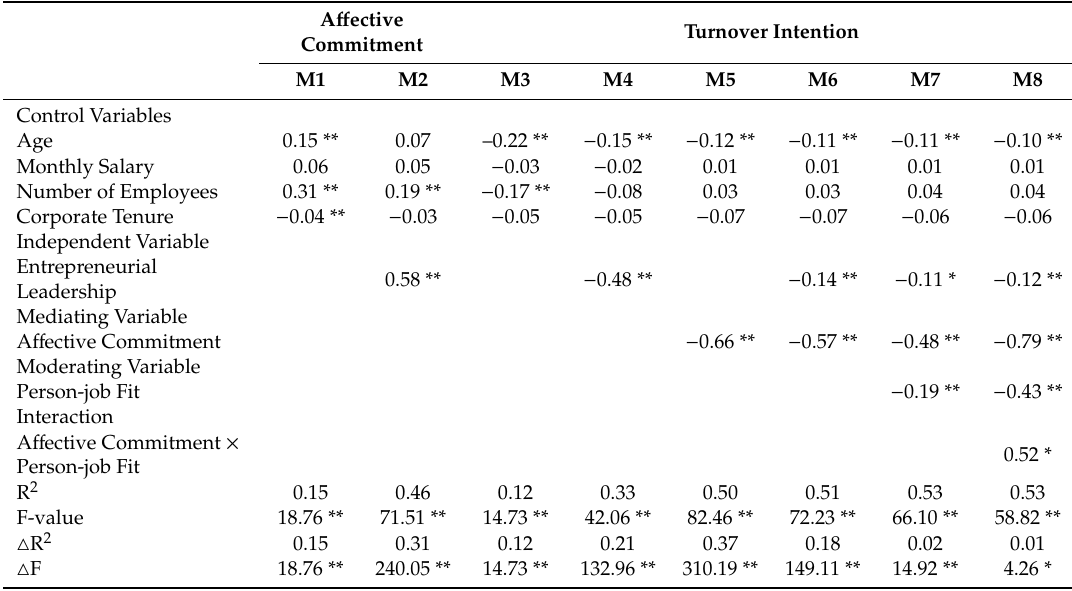
Table 3. Results of the hypothesis